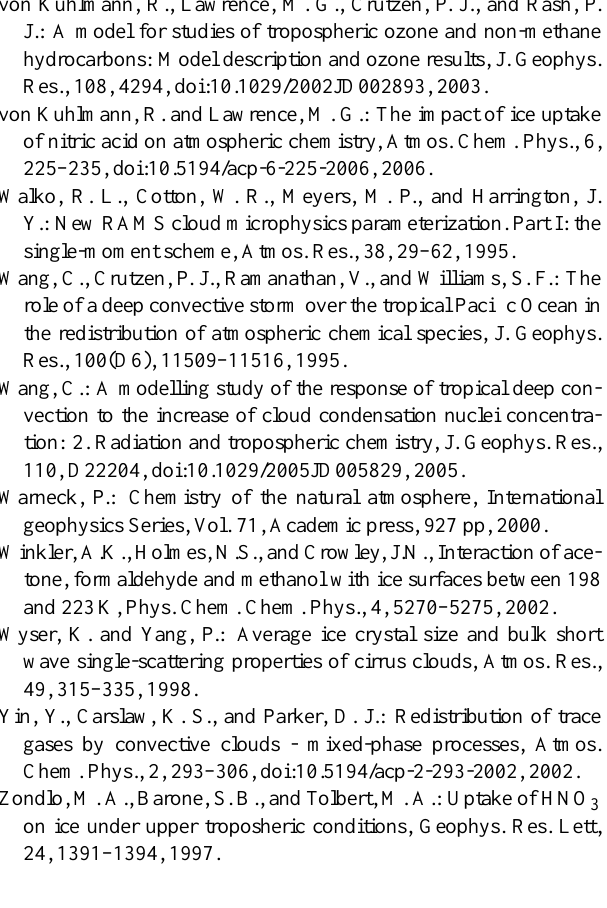
Tabazadeh, A. and Turco, R.: A model for heterogeneous chemical processes on the surfaces of ice and nitric acid trihydrate parti- cles, J. Geophy. Res., 98(D7), 12727–12740, 1993. Tabazadeh, A., Toon, O. B., and Jensen, E. J.: A surface chemistry model for nonreactive trace gas adsorption on ice: